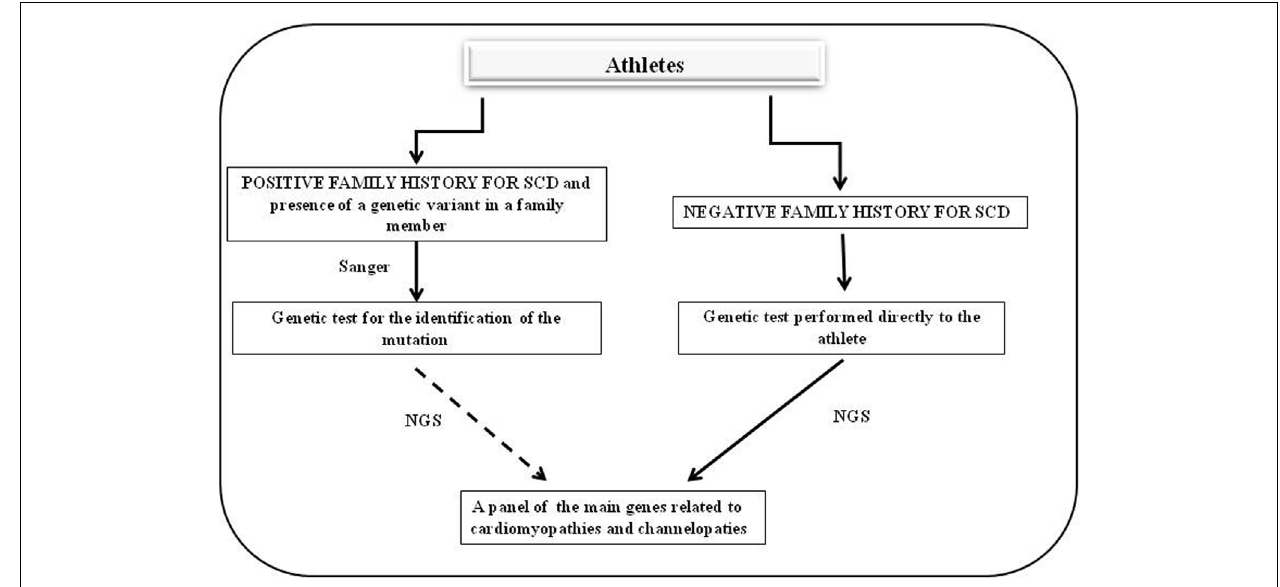
FIGURE 1 | Flow chart of genetic screening for athletes with suspected cardiac diseases. The left side shows the diagnostic protocol to follow in cases in which there is a positive family history for cardiac hereditary disease